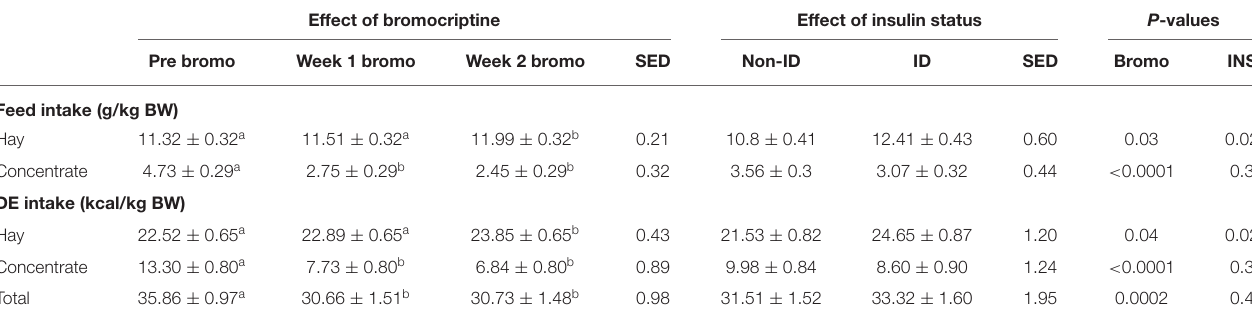
TABLE 4 | Effect of bromocriptine treatment and insulin status on daily feed and digestible energy intake (g/kg BW) on an as fed basis.